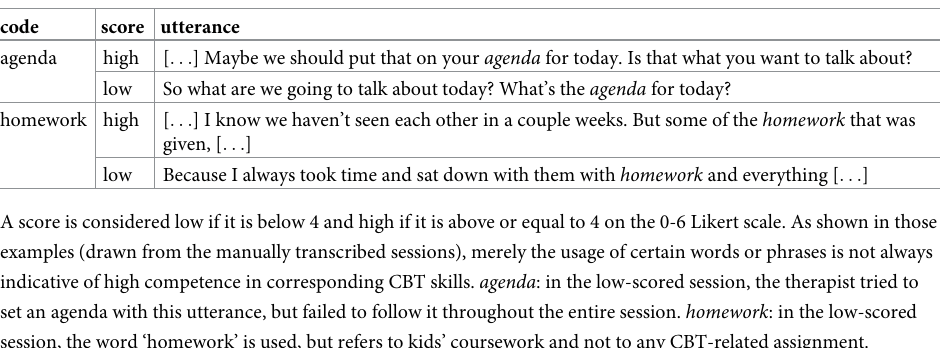
Table 2. Examples of utterances within sessions with high/low scores for the CTRS dimensions of agenda and